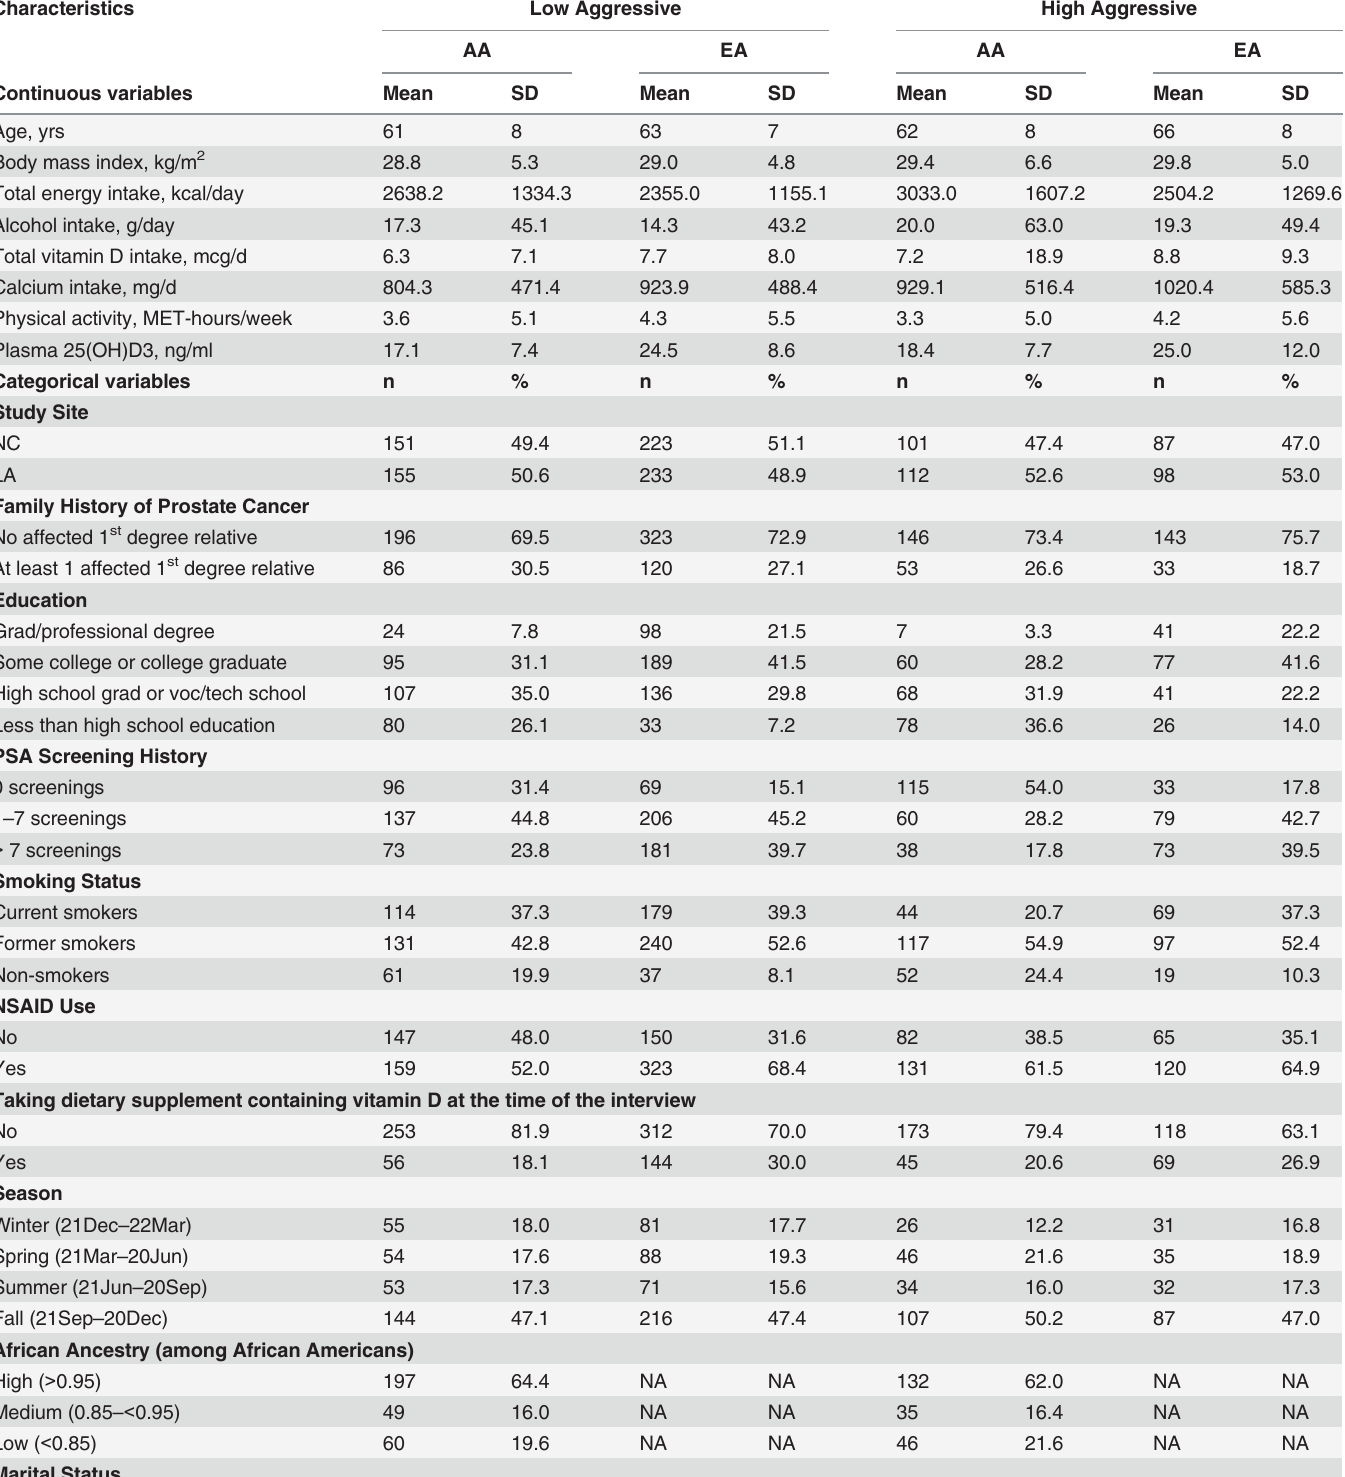
Table 1. Descriptive statistics by prostate cancer aggressiveness and